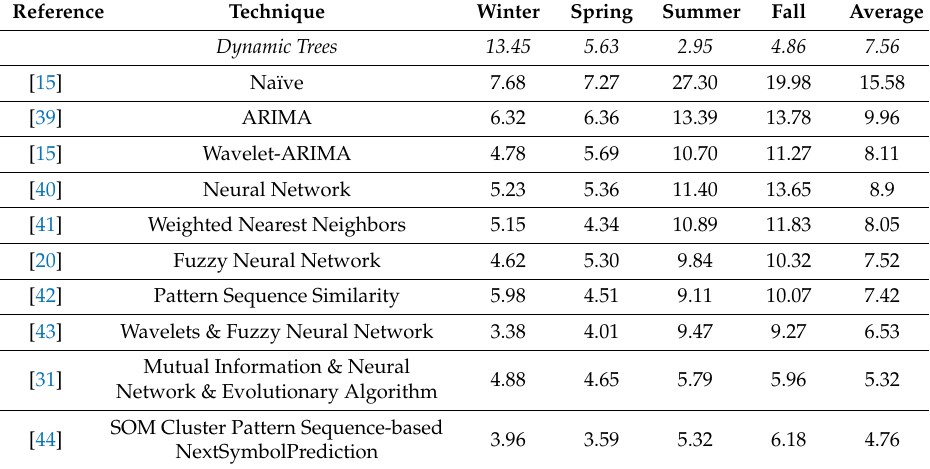
Table 11. Weekly MAPE (WMAPE) (%) for the four representative weeks of the four seasons of the year for several studies. As the results of our work (in italic) are for the year 2014 and the other studies are for the year 2002, these statistics must be treated with great care and so interpreted only in a qualitative way.